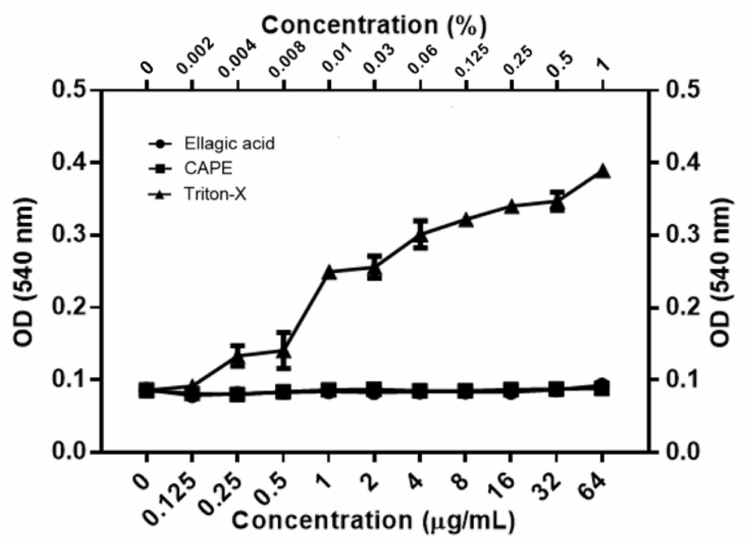
Figure 5. Cytotoxicity of EA and CAPE in human red blood cells. Triton-X was used as a positive control. Data represent the mean ± SD ( n = 3).